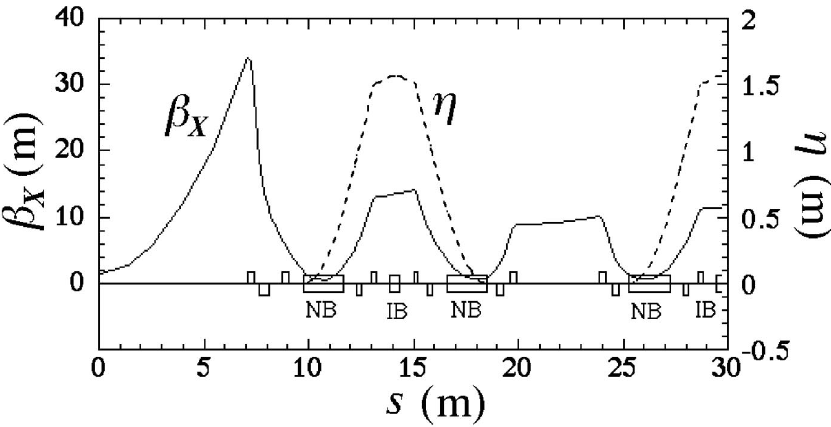
FIG. 1. Beta function ( (cid:4) , solid line) and dispersion function ( (cid:9) , broken line) in 1 = 4 of NewSUBARU. The boxes indicate the X locations and lengths of the bending magnets (indicated by NB and IB) and quadrupole